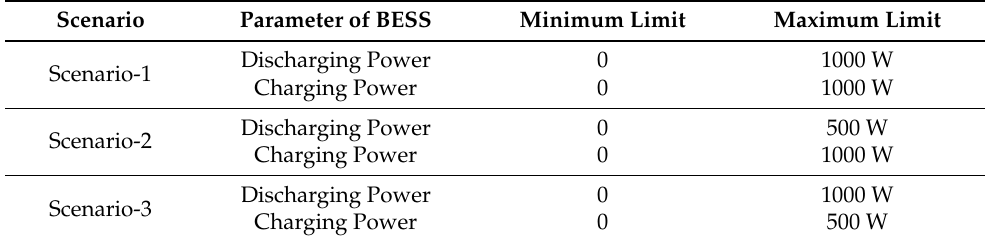
Table 1. Discharging and charging power limit of BESS.